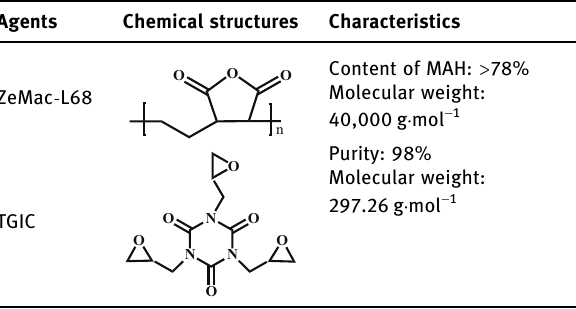
Table 1: Chemical structures of modi fi ers used in this